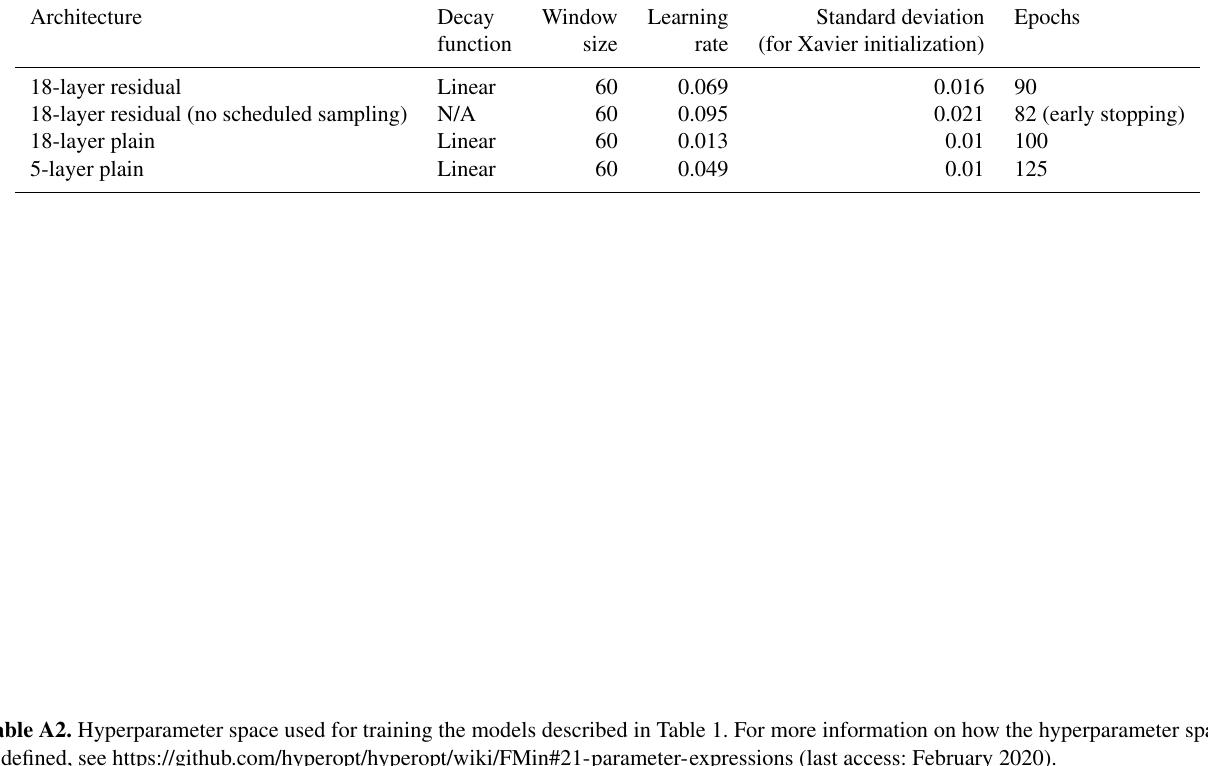
Table A2. Hyperparameter space used for training the models described in Table 1. For more information on how the hyperparameter space is defined, see https://github.com/hyperopt/hyperopt/wiki/FMin#21-parameter-expressions (last access: February 2020).